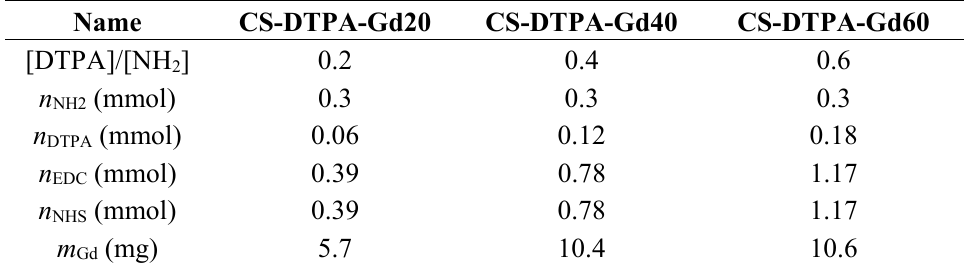
Table 1. DTPA feed ratio and the final concentration of gadolinium.